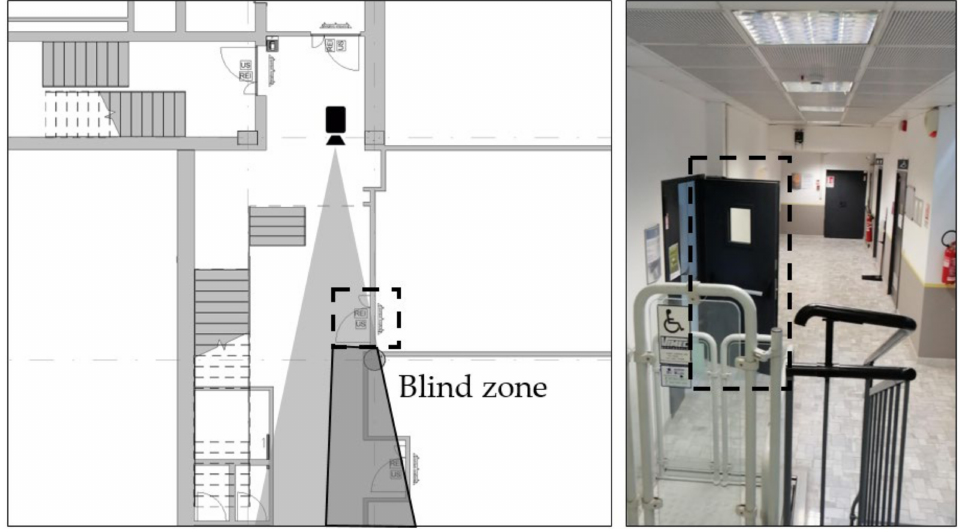
Figure 11. Unexpected blind zone generated by unusual occupants’